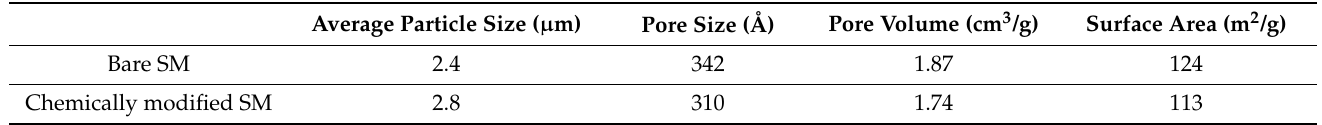
Figure 2. Particle size distribution ( A ) and pores size distribution ( B ) of bare and chemically modified silica monolith. Table 1. Particle size, pore size, pore volume and surface area of bare and chemically modified silica monolith